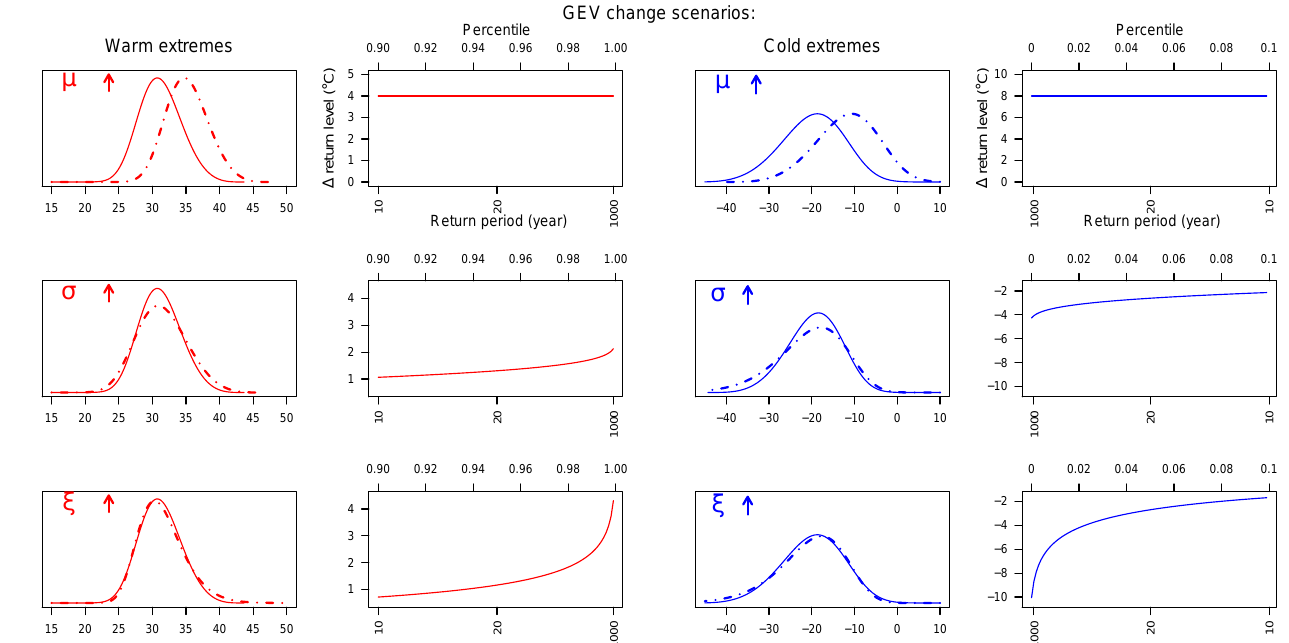
Figure 3. Illustration of the effect on return levels of changing individual GEV parameters. We show consequences for both warm (red, left columns) and cold (blue, right columns) extremes. Columns 1 and 3 show GEV distributions for baseline (solid) and future (dashed) climates. Columns 2 and 4 show resulting changes in return levels for different return periods. Note that 1000-year periods are on the right for warm and left for cold extremes, to conform with percentiles. Location and shape parameters used here are chosen as representative of our model results, with larger effects in cold extremes than warm extremes, while shape parameters are identical in both cases. Top row: changing the location parameter shifts return levels uniformly across return periods. Middle row: increasing the scale parameter produces effects dependent on return period. All return levels increase (decrease for cold extremes), but more so for longer return periods. Bottom row: increasing the shape parameter produces dramatic increases in return levels at very long return